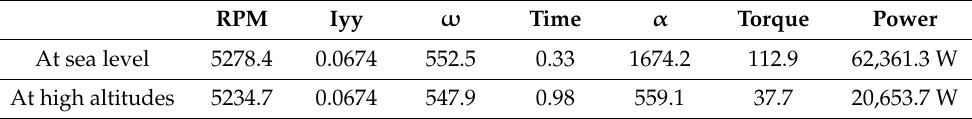
Figure 14. Relationship between rpm and time step. Table 2. Power of rotor